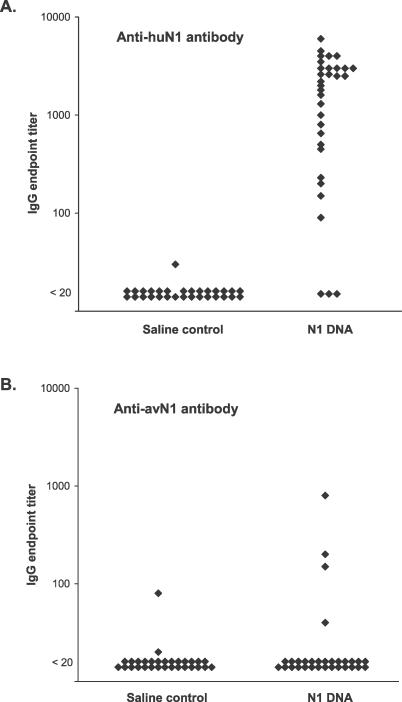
NA-Specific Antibody Responses to ImmunizationSerum was collected from BALB/cJ mice after two injections with plasmid encoding the NA of human H1N1 influenza strain A/New Caledonia/20/99 (huN1) or saline only. Antibody reactivities with huN1 and the NA of H5N1 influenza strain A/Vietnam/1203/04 (avN1) were determined by ELISA.(A) Between the huN1 DNA and saline-only treatment groups there was a statistically significant difference in mean IgG titers against huN1 (p < 0.001).(B) IgG titers detected against avN1 were not significantly different between the treatment groups (p = 0.092). The antibody titer against each target was defined as the reciprocal of the highest serum dilution that produced an ELISA signal twice as intense as the signal from equivalently diluted naïve serum. The lower limit of detection was a titer of 20.